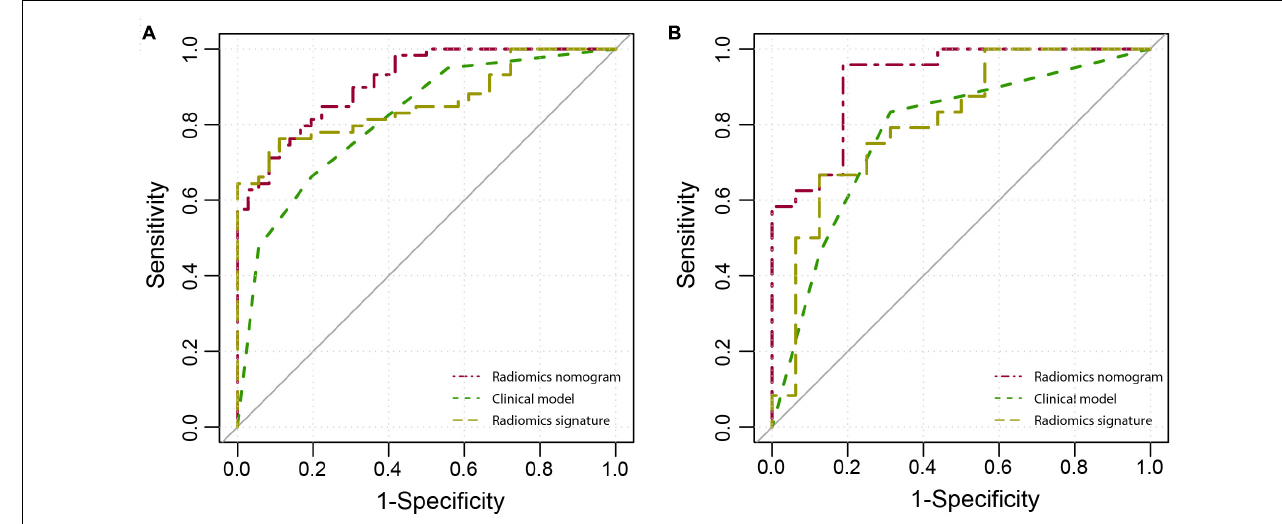
FIGURE 4 | The receiver operator characteristic (ROC) curves of the radiomics nomogram, clinical model, and radiomics signature in the training (A) and validation (B) cohorts.